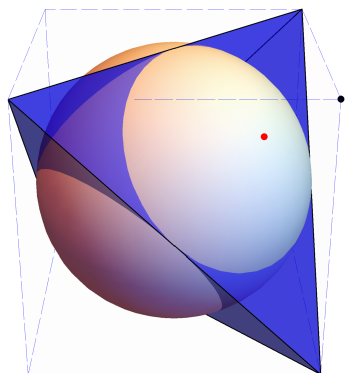
FIG. 6. The qubit version of the Torpedo Game has a perfect strategy when allowed access to postquantum “states.” The red point on the surface of the Bloch sphere represents the optimal (cid:4) (cid:5) (cid:4) ψ , achieving a value of 0.79 for the Torpedo message state 0,0 [ I − ( X + Y + Z ) ] is not Game. The black point representing 1 2 a valid density matrix, but achieves a value of 1 in the Torpedo